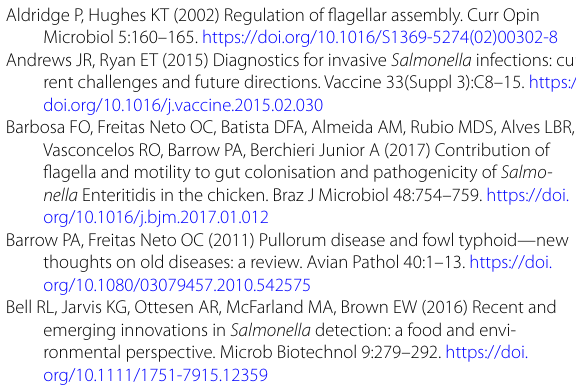
Additional file 1: Fig. S1. Phylogenetic analysis based on predicted amino acid sequences of FliC. Fig. S2. Similarity analysis of the amino acid sequence of FliC from different serotype of Salmonella